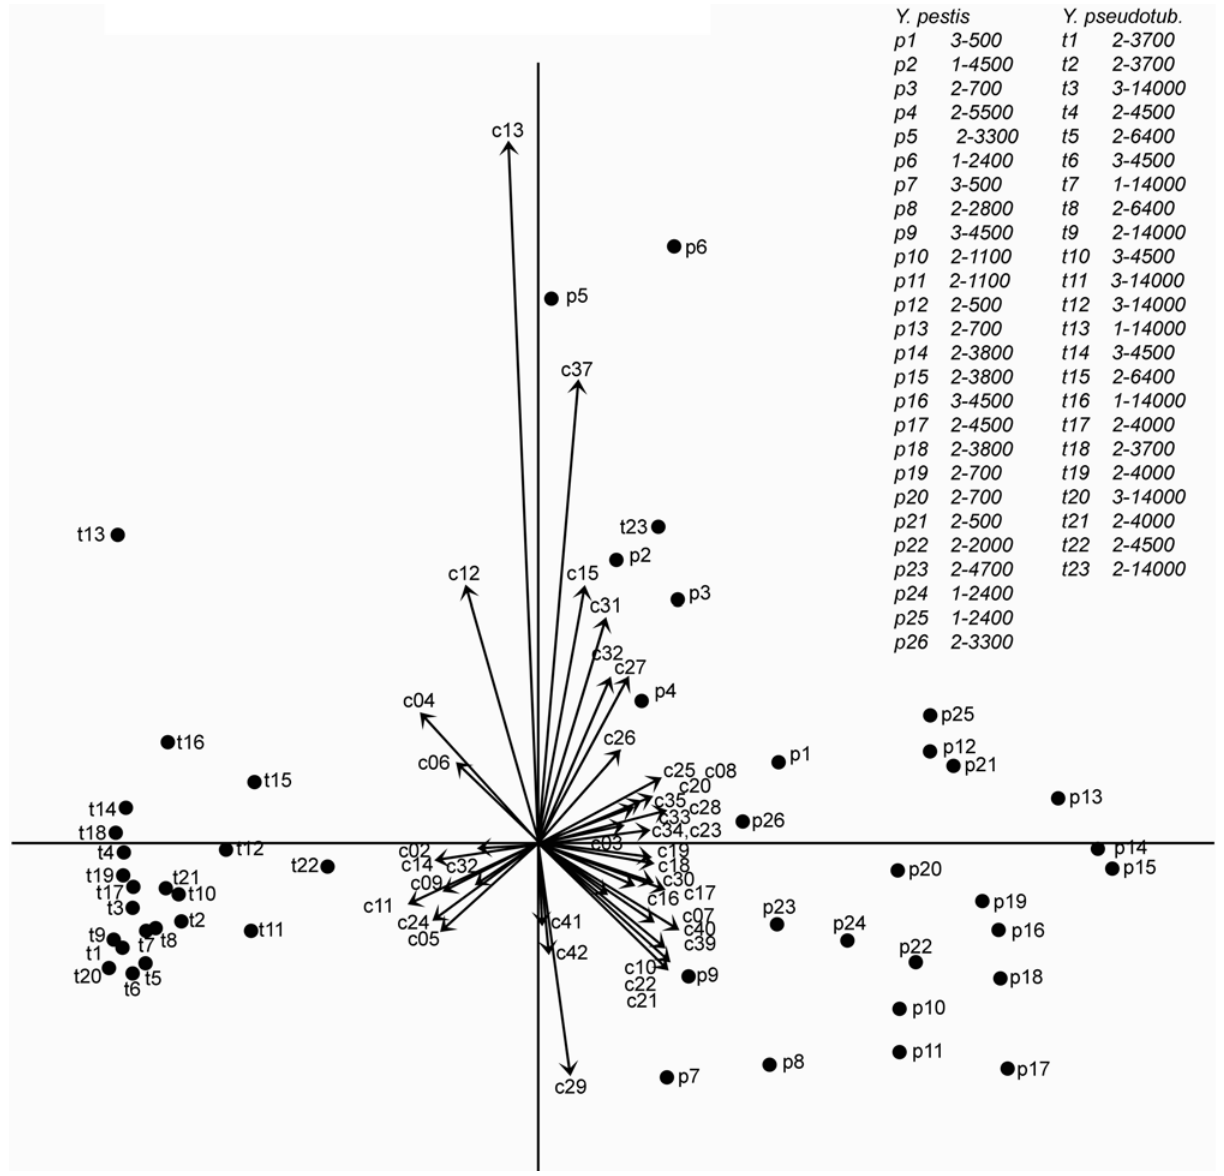
Figure 8. Multiple Correspondence Analysis of type 2 and type 3 histopathological profiles. The types 2 and 3 histopathological profiles represented in the dendrogram of Figure 7, excepted the completely destroyed profiles, were included in the analysis. Here is shown a graphical display of the results of the Multiple Correspondence Analysis, on the first two dimensions. Criteria, numbered as in Table 1, are represented by arrows. Lymph nodes are represented by dots and denoted by alpha-numerical labels which are listed in the accompanying table, at the top right of the figure. In this table are indicated, for each DLN, first, the time interval (in days) between mouse infection and lymph node collection, then, the number of injected cfu. It can be seen that Y. pseudotuberculosis - and Y. pestis -infected lymph nodes are grouped on the left and right sides of the figure, respectively. Therefore, criteria on the left side of the figure are associated with Y. pseudotuberculosis profiles and criteria on the right side of the figure are associated with Y. pestis profiles. Criteria that are closest to the first (horizontal) axis are the most discriminating between the two groups.